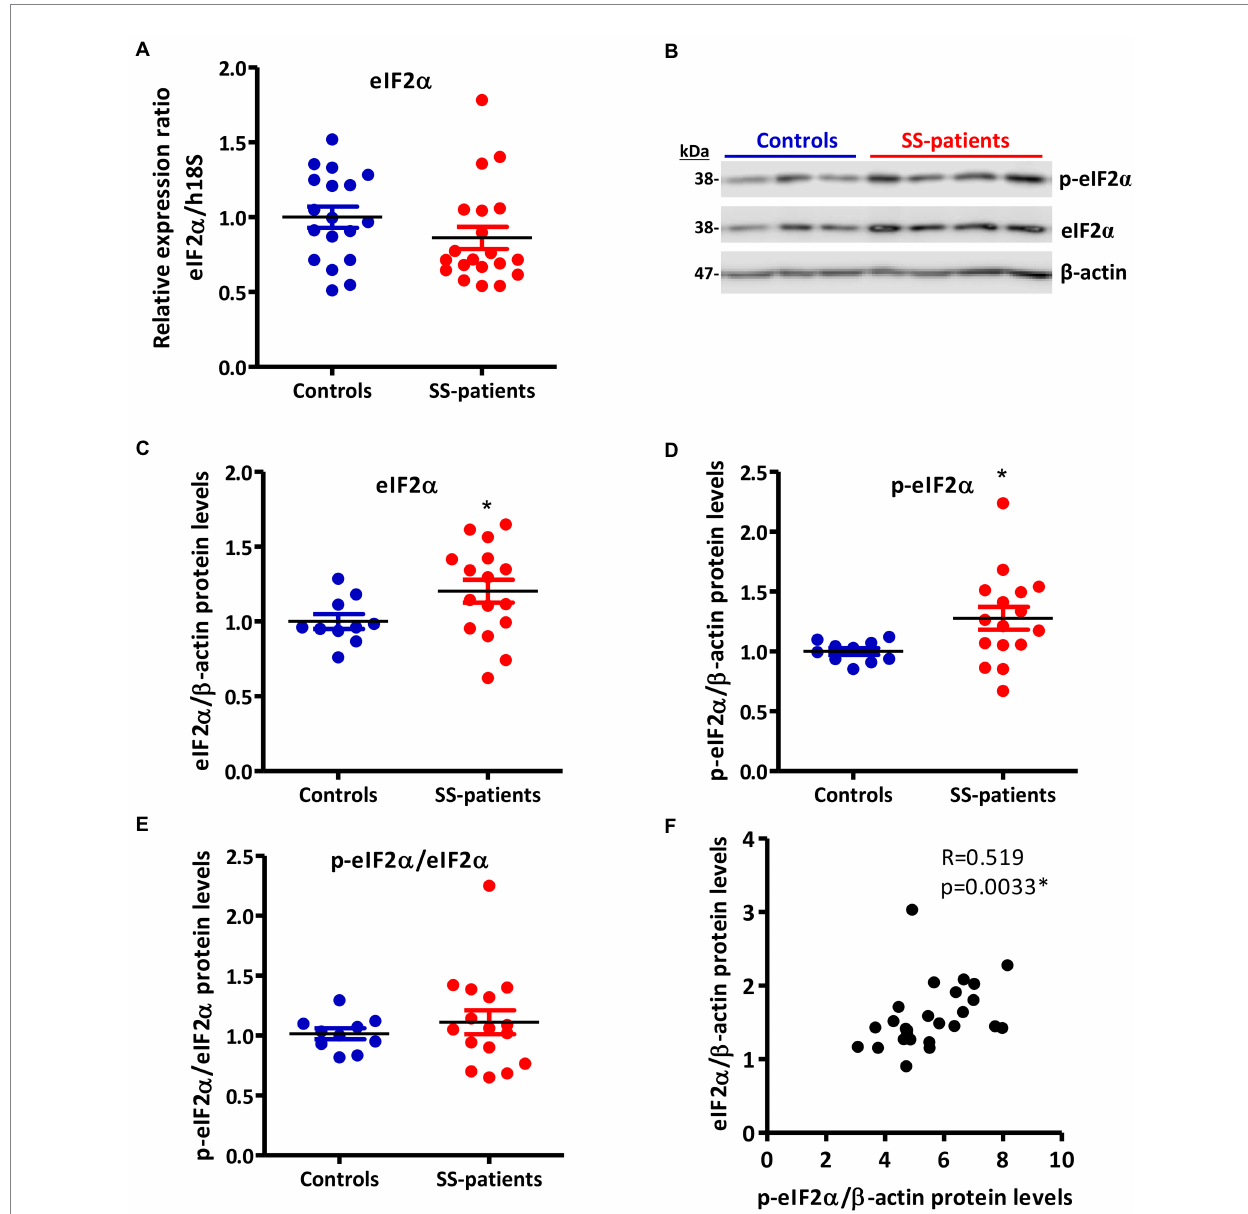
FIGURE 8 Expression of eIF2 α and p-eIF2 α in LSGs from control and SS-patients. (A) Dot plot showing eIF2 α transcript levels relative to h18S from controls (C) and SS-patients (P) ( n = 18C, 20P). (B) Representative images of p-eIF2 α and eIF2 α immunoblots from control and SS-patients using β -actin as a loading control. (C) Dot plot showing densitometric analysis of eIF2 α ( n = 10C, 16P). (D) Dot plot showing densitometric analysis of p-eIF2 α ( n = 10C, 16P). (E) Dot plot showing the p-eIF2 α /eIF2 α ratio ( n = 10C, 16P). (F) Spearman’s correlation between p-eIF2 α and eIF2 α protein levels. These experiments were repeated at least three times (*). p values lower than 0.05 were considered